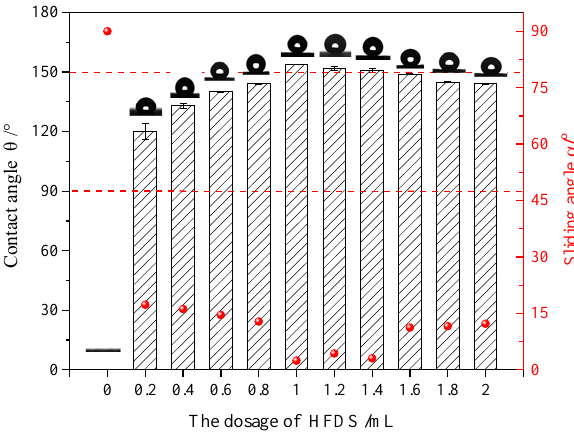
Figure 6. Influence of the amount of 1H,1H,2H,2H-perfluorodecyltriethoxysilane (HFDS) additive on the coating hydrophobicity (bar: contact angle, red dot: sliding angle; 5 g UFA, 50 mL